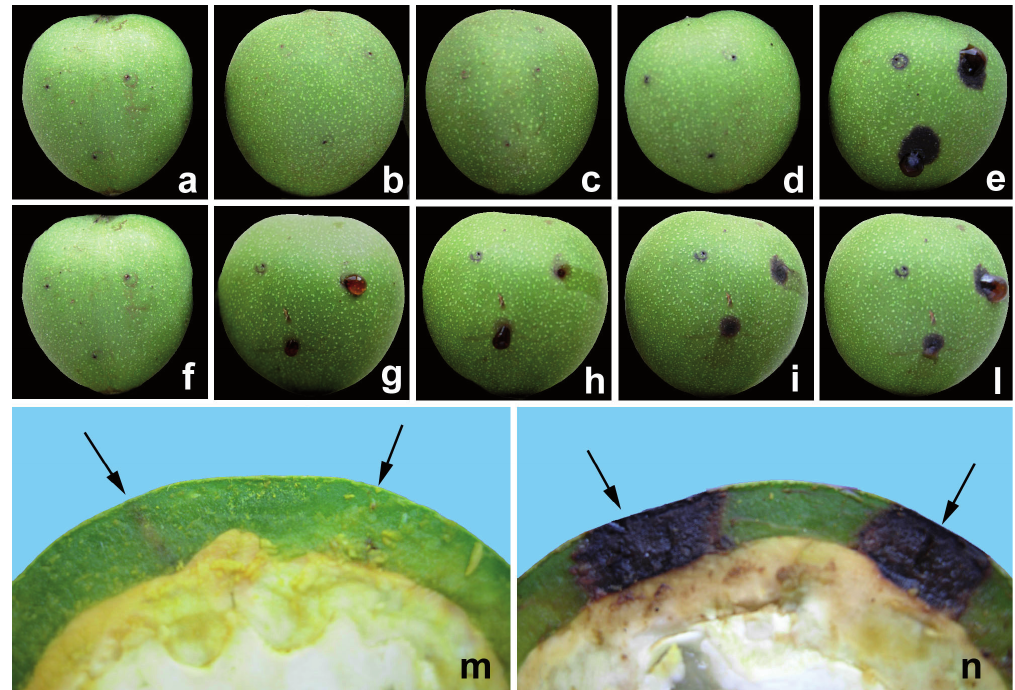
Figure 1. Symptoms on immature walnut fruits inoculated with Brenneria nigrifluens DAPP-PG 509 using the syringe without needle technique. Fruits infiltrated with water (a) or bacterial suspension at 10 5 (b), 10 6 (c), 10 7 (d) and 10 8 (e) cells mL -1 , 8 days after inoculation. Fruits infiltrated with water (f) or the bacterium (10 8 cells mL -1 ) after 2 (g), 4 (h), 6 (i) and 8 (l) days after inoculation. Control (m) and inoculated (n) fruits sectioned at the inoculation sites (arrows), 8 days after inoculation. Necrotic symptoms occur in the walnut mesocarp, around the inoculation sites, and expand in the endocarp.